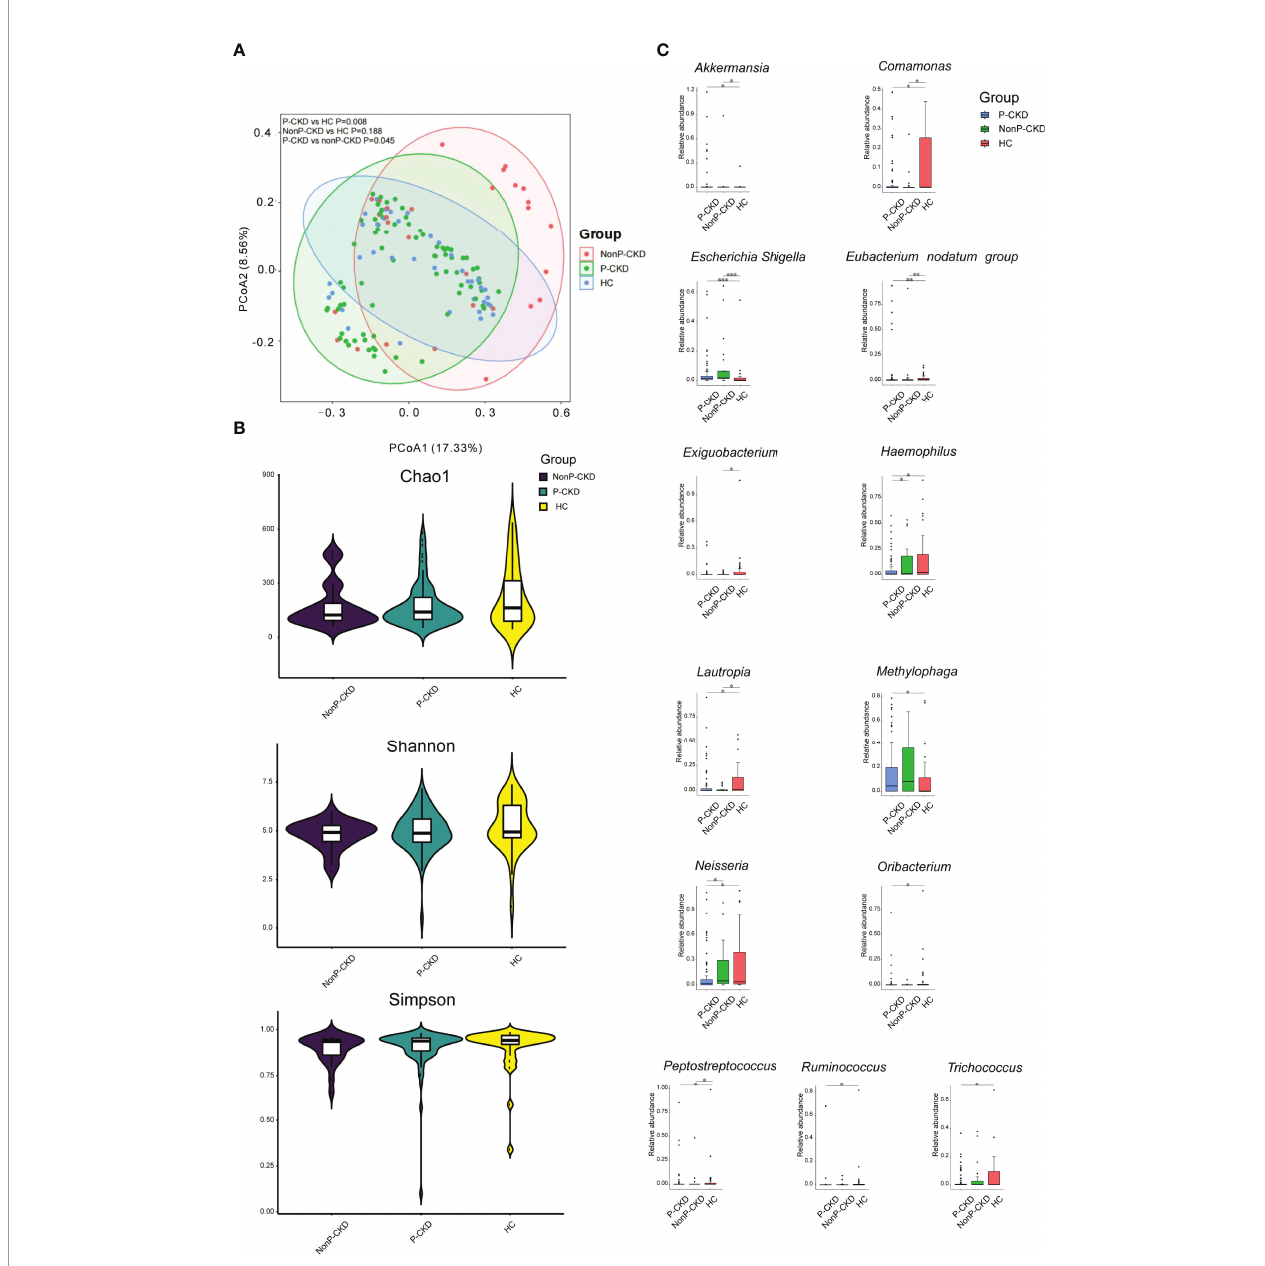
FIGURE 4 | Bacterial community, diversity, and genus comparison in the groups P-CKD, nonP-CKD, and HC. (A) PCoA based on Bray – Curtis distances at ASV level showed different microbial compositions among P-CKD, non-P-CKD, and HC. Permutational multivariate analysis of variance (PERMANOVA) was performed for statistical comparisons of samples in the three groups. p -value was adjusted by the Benjamini and Hochberg false discovery rate (FDR). (B) Bacterial richness and diversity measured by Chao1, Shannon, and Simpson were calculated at the microbial ASV level. Wilcoxon rank-sum test was performed and adjusted by Benjamini and Hochberg false discovery rate (FDR). (C) Comparison of the abundances of bacterial genus in P-CKD, non-P-CKD, and HC. Wilcoxon rank-sum test was performed and adjusted by Benjamini and Hochberg false discovery rate (FDR). * p < 0.05, ** p < 0.01, and *** p <